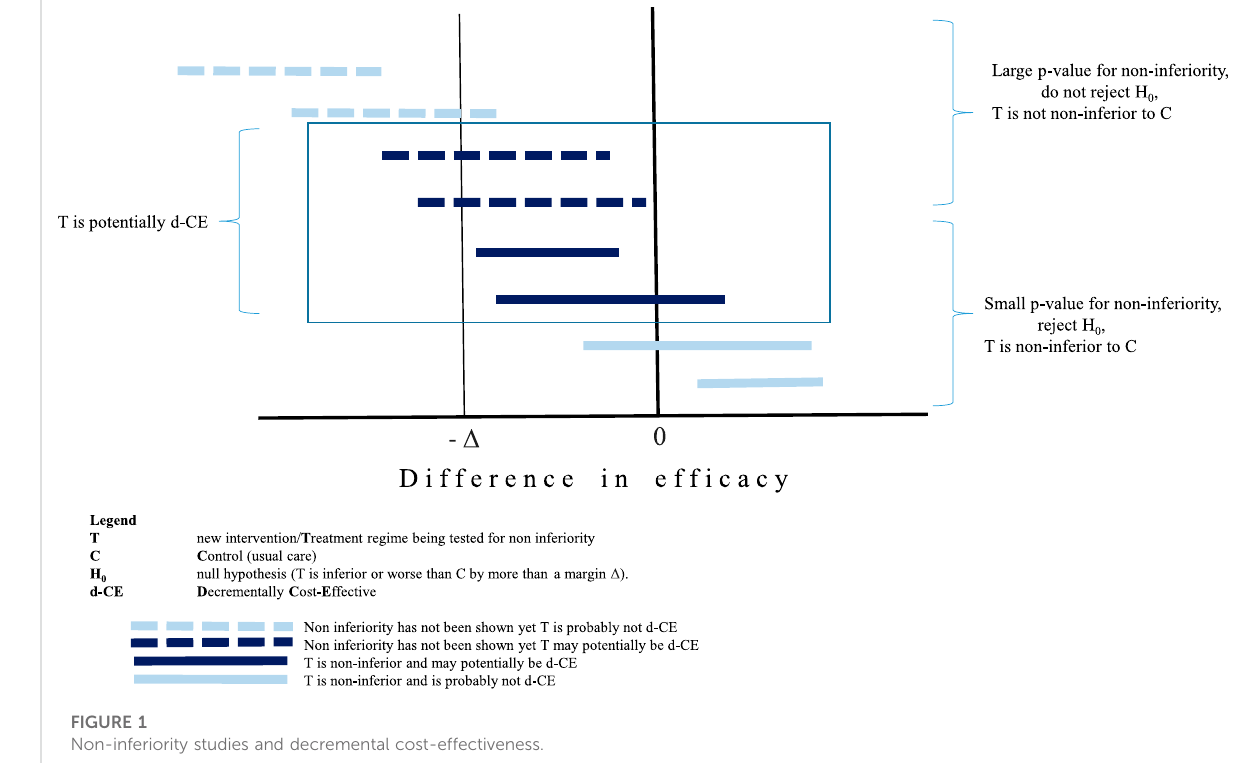
FIGURE 1 Non-inferiority studies and decremental